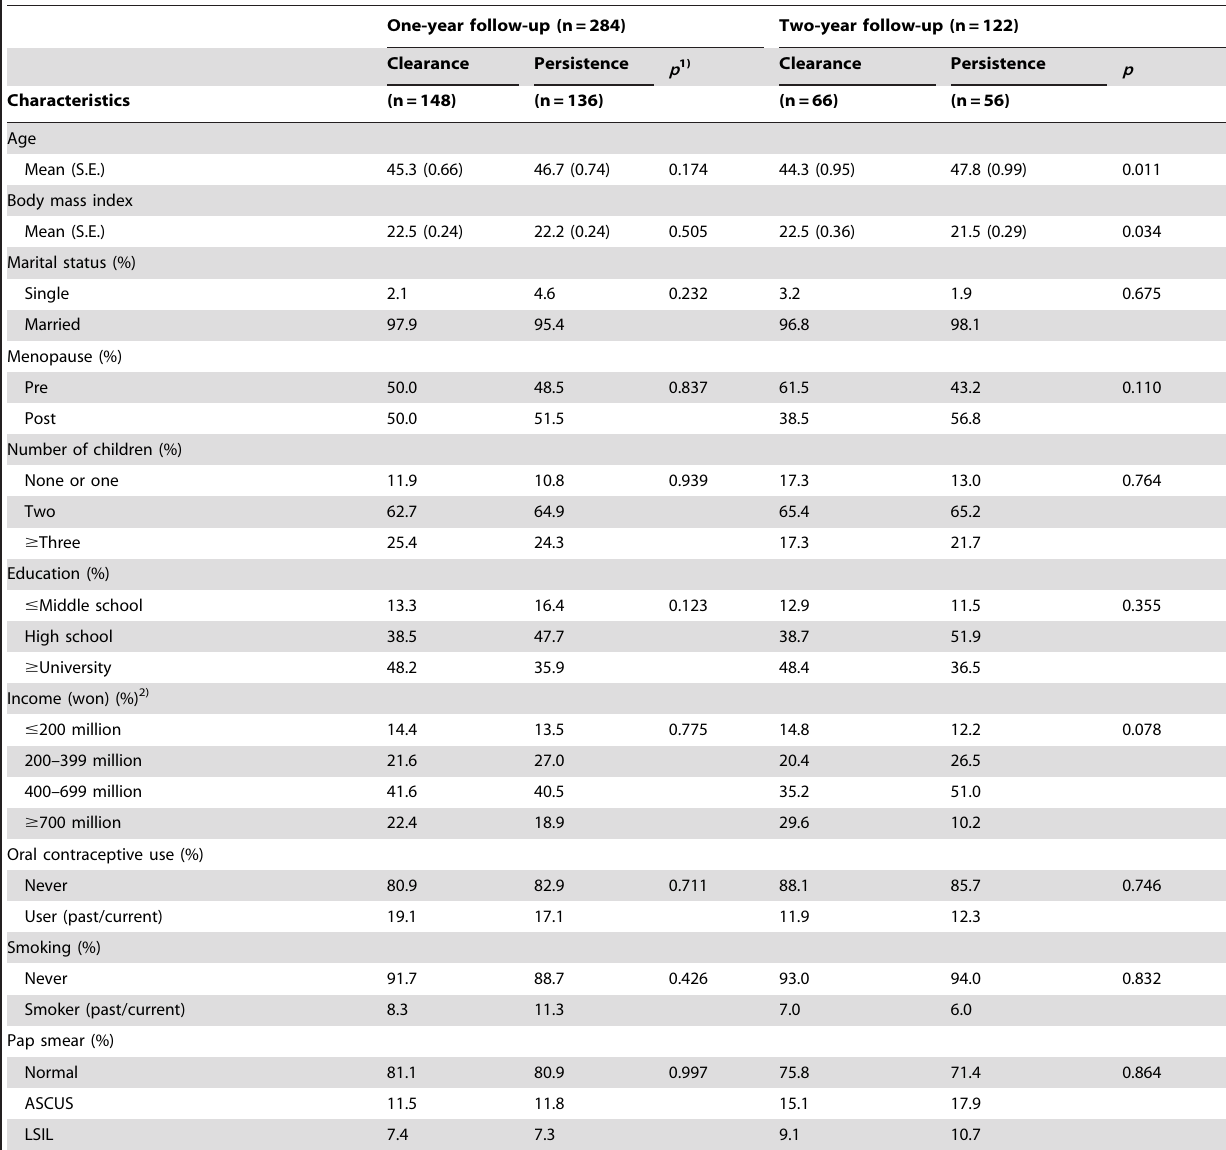
Table 2. General characteristics of the study